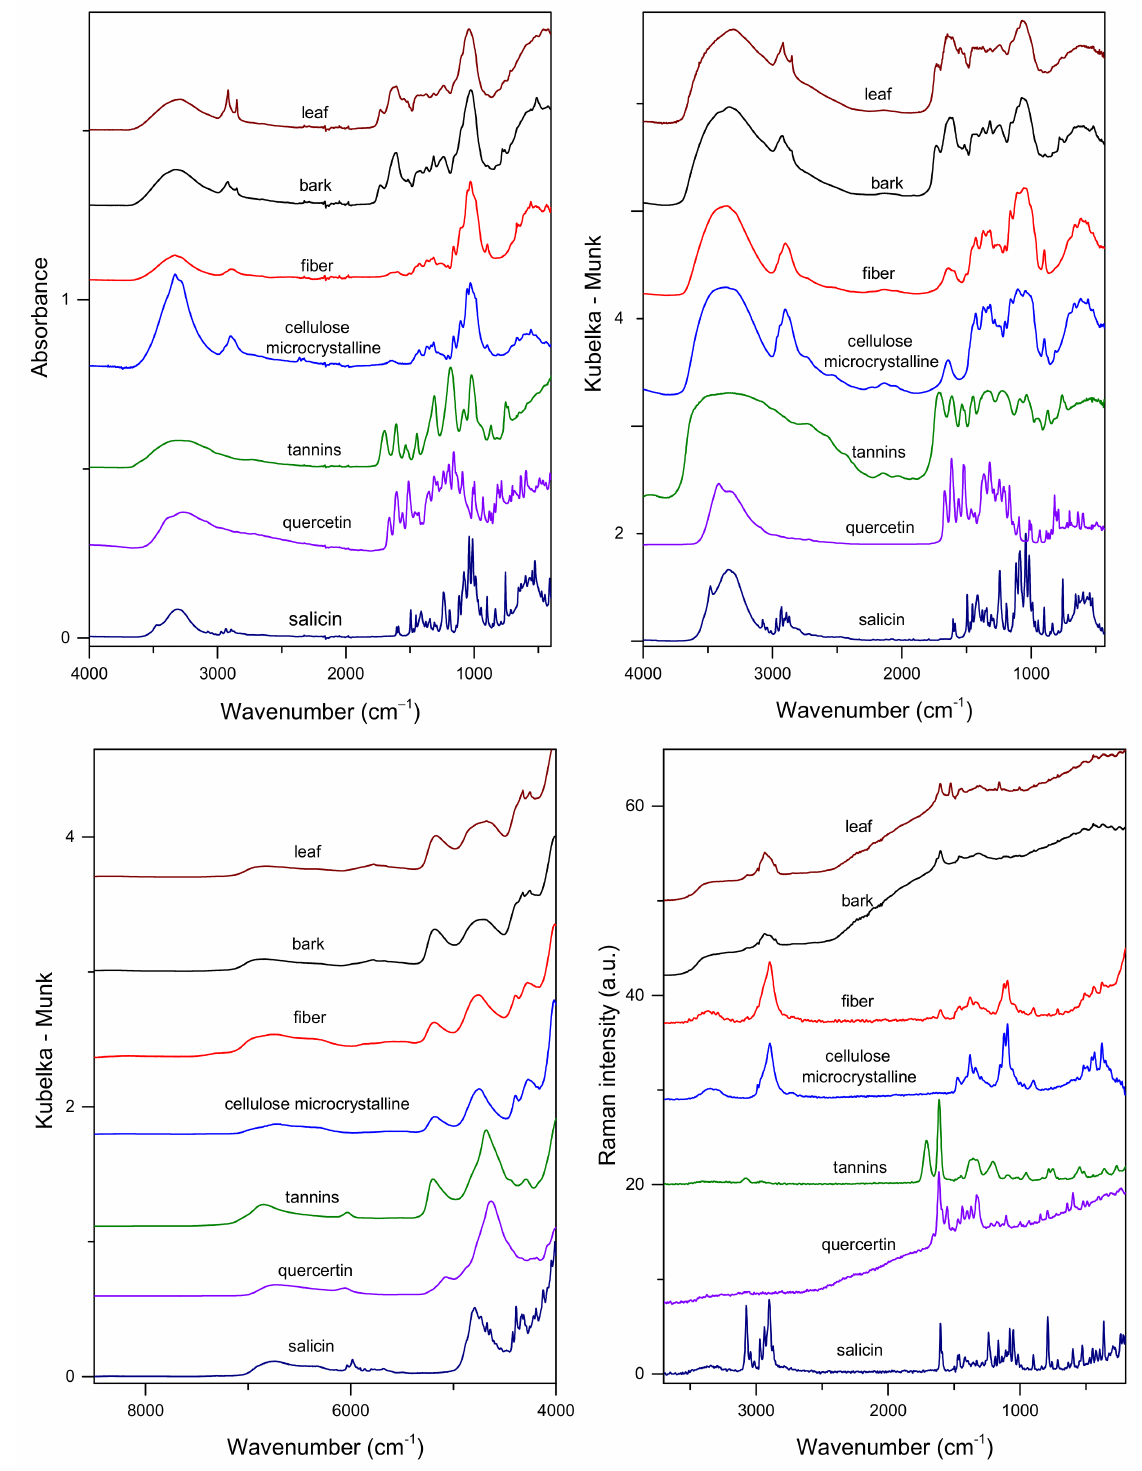
Figure 2. Vibrational spectra of poplar bark, leaves, and reference compounds: top panel—ATR ( left ) and DRIFTS ( right ) and bottom panel—NIR ( left ) and Raman ( right